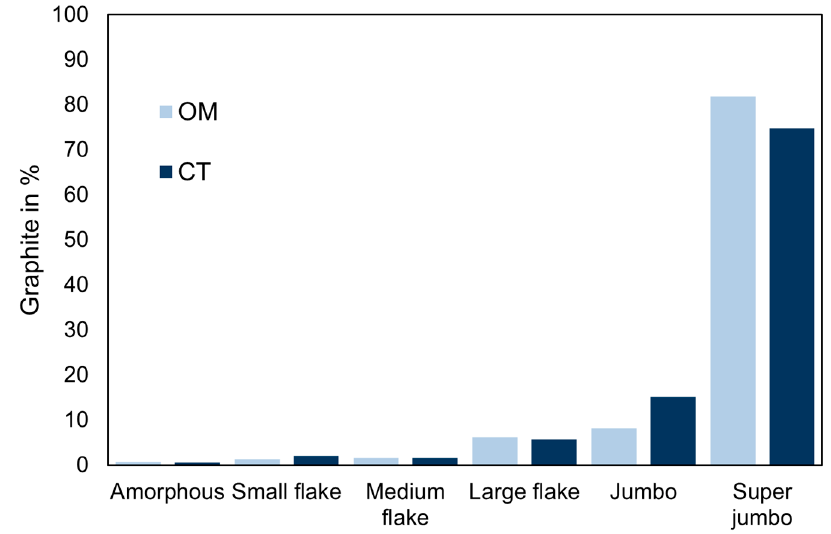
Figure 13. Histogram showing the size distribution of graphite, as determined on a polished section using OM and on the sample volume topmost slice using CT.